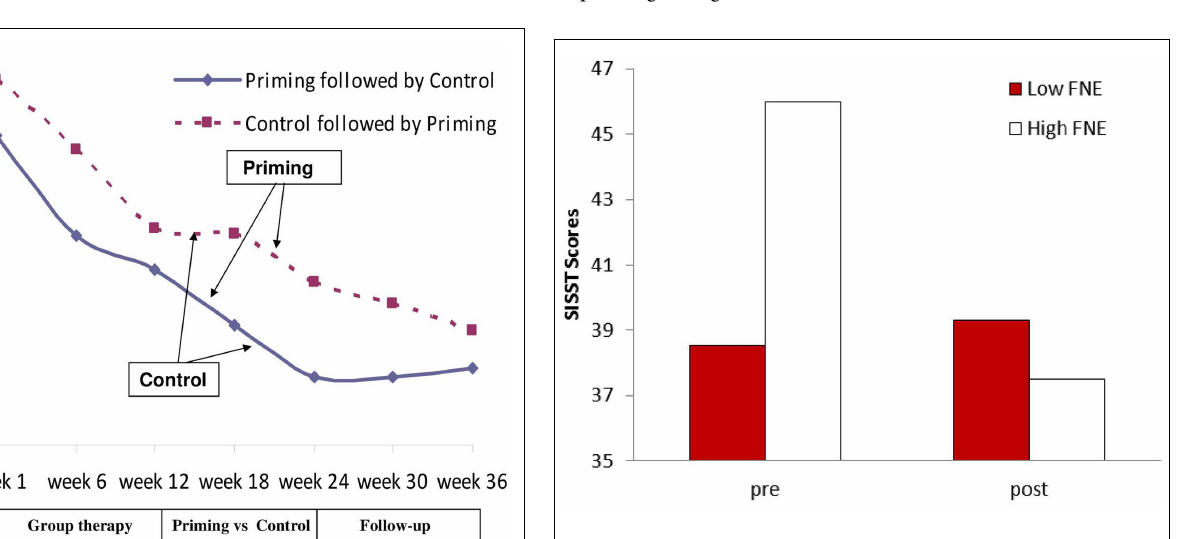
FIGURE 4 | Comparison of patients with lower FNE (fear of negative evaluation) scores at the end of group therapy vs. patients with higher FNE scores on their response to preconscious priming of SISST-negative statements: F (1,12) = 14.08, p = 0.003